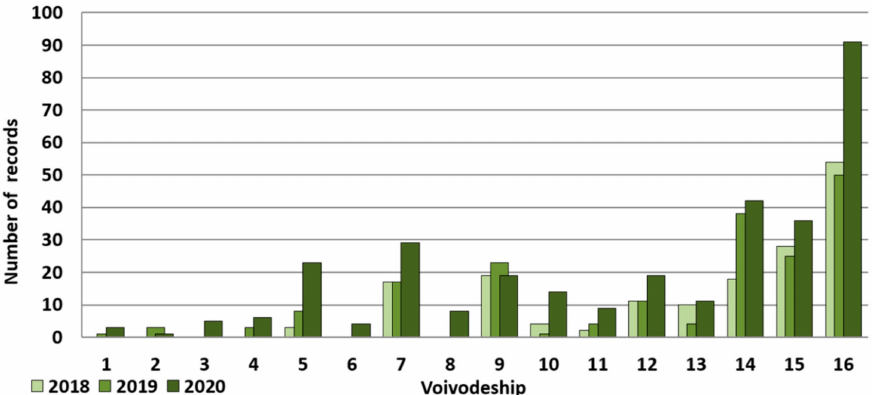
Figure 6. The number of confirmed records of Cydalima perspectalis occurrence in individual voivode- ships in 2018–2020. Axis X: 1–16—numbers assigned to individual voivodships; see Table